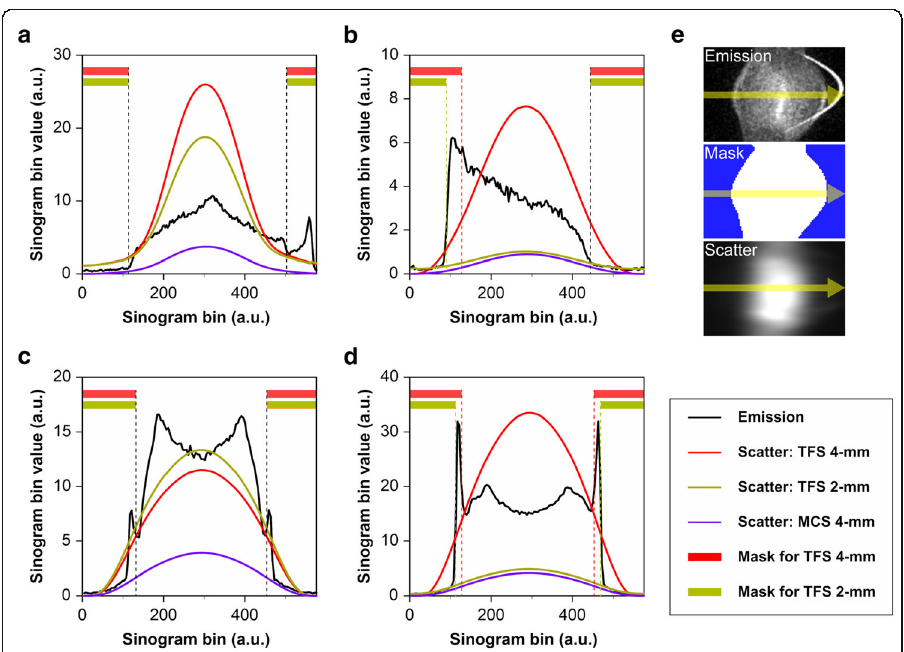
Fig. 6 Sinogram profiles on halo-artifact regions from a random-corrected emission sinogram ( thick black solid line ), scatter sinogram ( red solid line: TFS 4-mm, green solid line : TFS 2-mm, blue solid line : MCS 4-mm), and mask for TF-SSS ( red region : for TFS 4-mm, green region : for TFS 2-mm). Patient data are shown in a and b . Phantom data are shown in c and d . Panels a and c are the urine shift pattern. Panels b and d are the tube curve pattern. e Example of sinogram images and profile lines